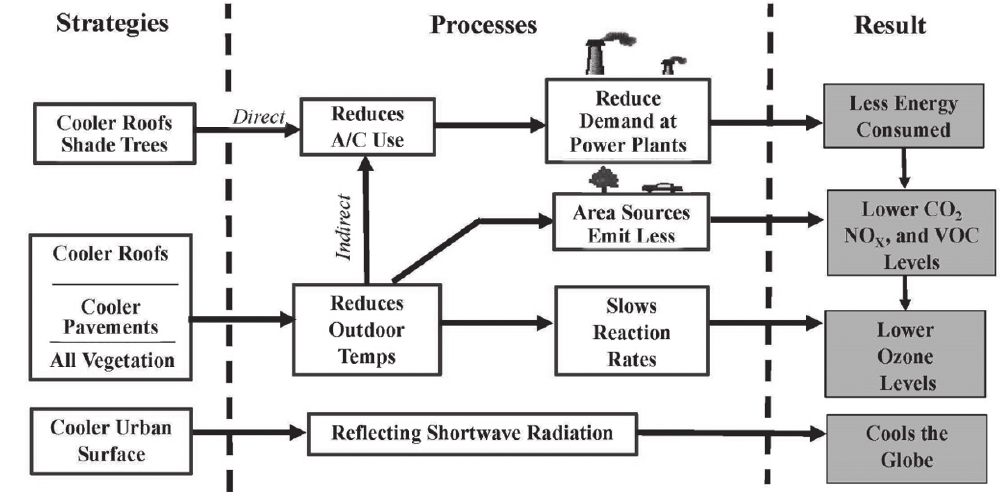
Fig. 1. effects of heat island